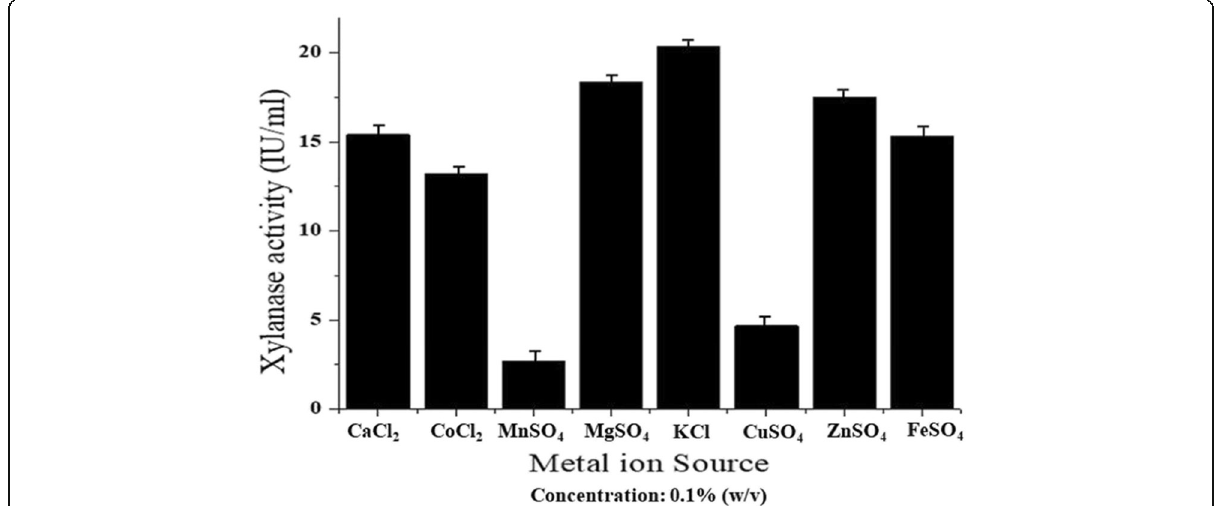
Fig. 7 Effect of different metal ion sources on xylanase activity of the bacterium Pseudomonas mohnii